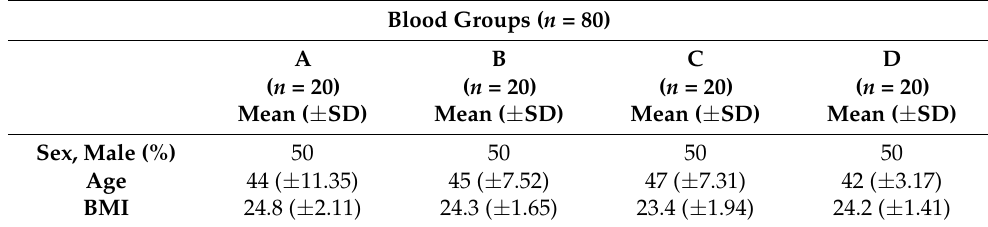
Table 1. Characteristic of all study